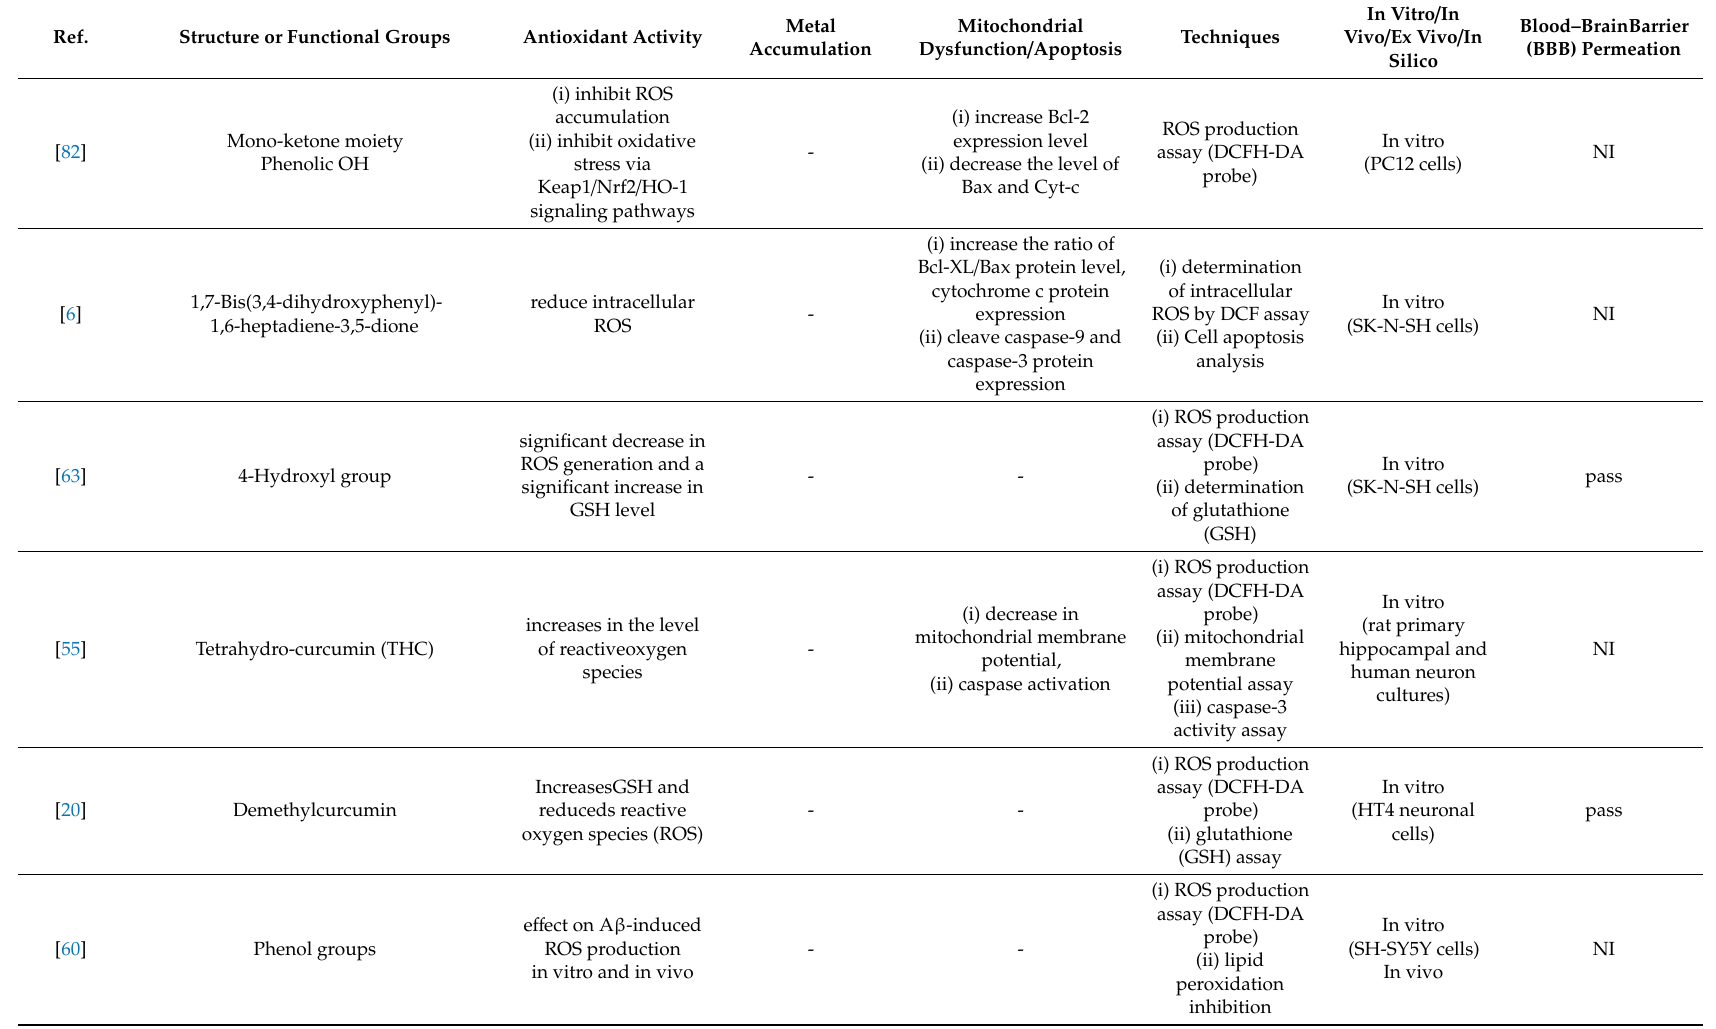
Table 2. Oxidative stress properties of curcumin analogues, derivatives, and hybrids in AD.